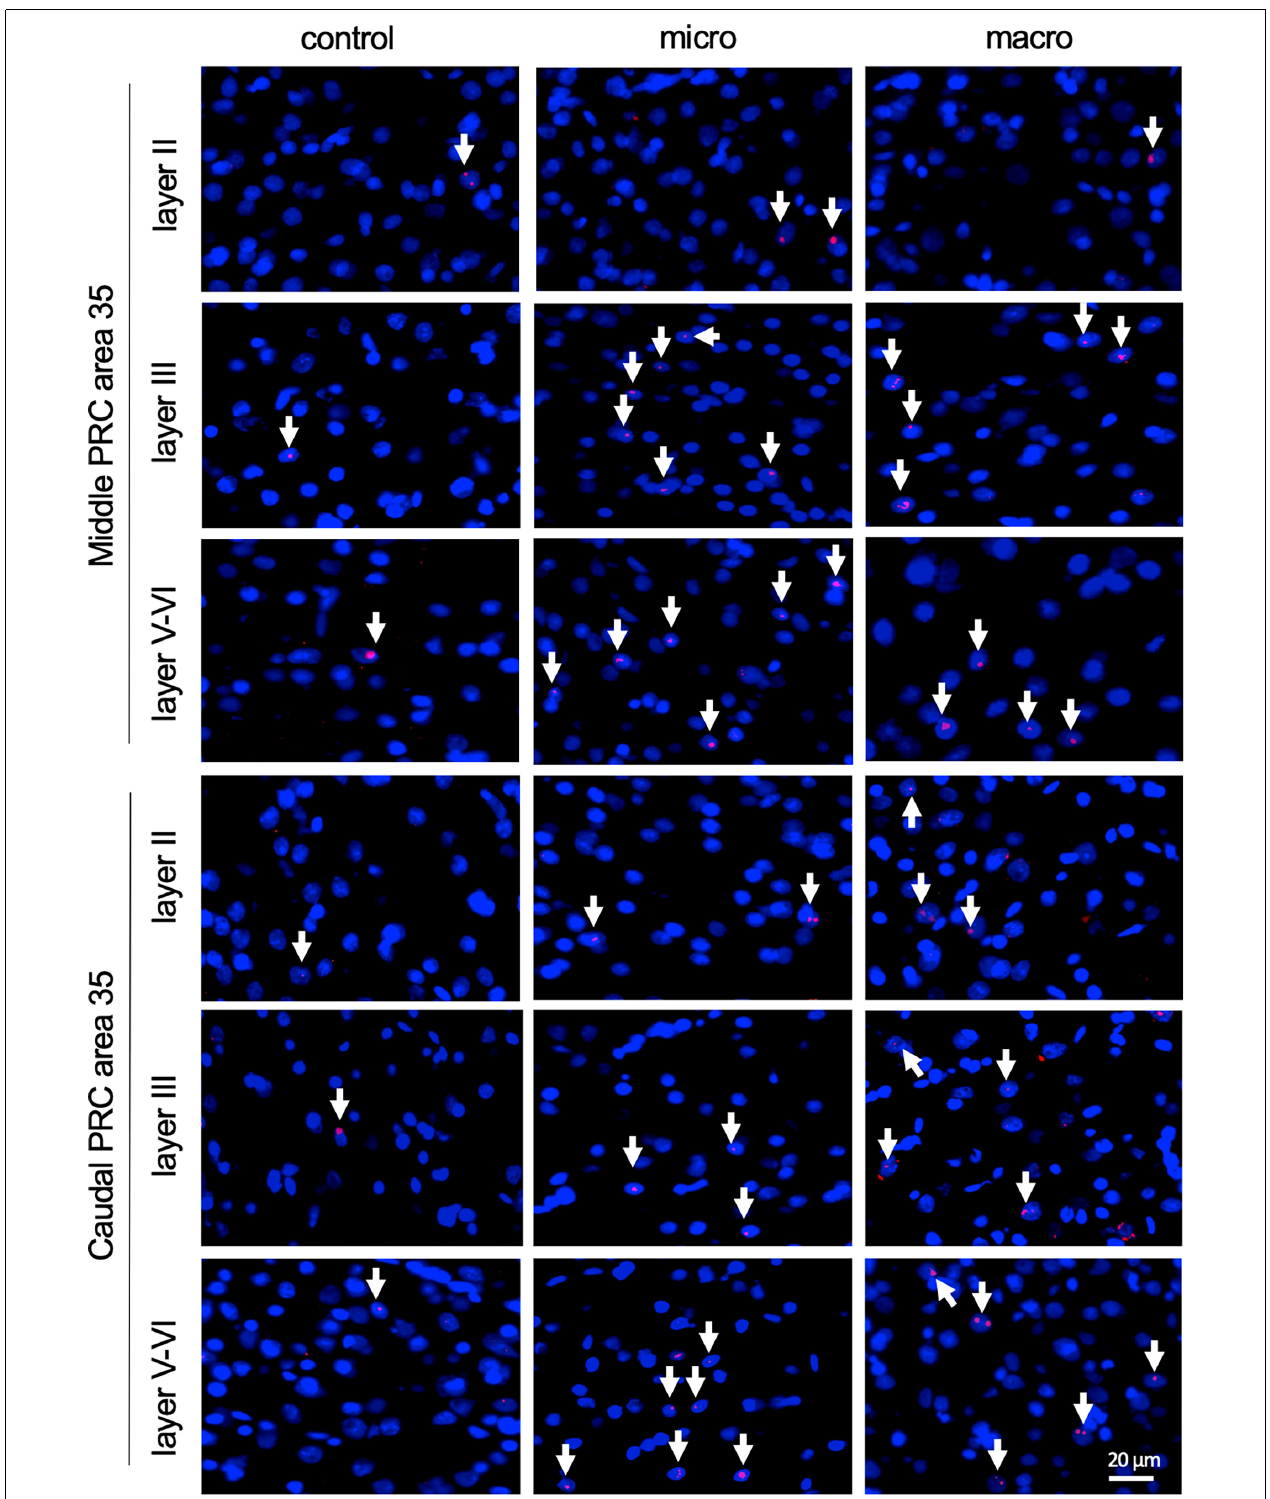
FIGURE 4 | Nuclear Arc mRNA expression in the superficial and the deep layers of area 35 upon exposure to novel items. Photomicrographs showing nuclear Arc mRNA expression (red, indicated by white arrows) in layer II (top), III (middle), and the deep layers (bottom) of the middle and caudal area 35 of control animals (control) or animals that participated in microscale (micro) or macroscale (macro) item exploration. Nuclei (blue) are stained with DAPI. Images were taken using a 20x objective. Scale bar: 20 µ m.